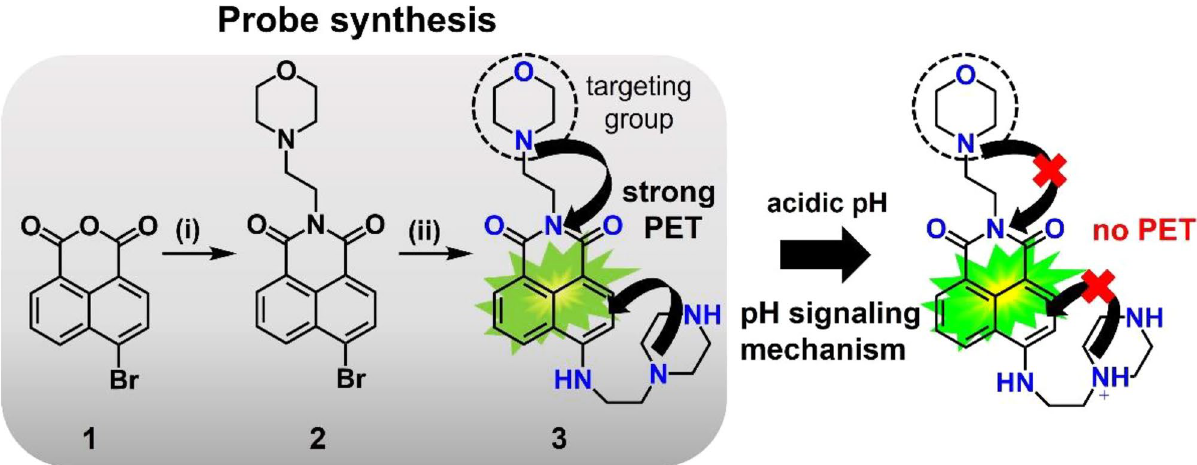
Figure 1. Synthesis of the hydrophilic neutral optical pH probe 3 designed for lysosomal targeting and its pH signaling mechanism; (i) 4-(2-Aminoethyl) morpholine, ethanol, 50 °C,5 h; (ii) 1-(2-Aminoethyl) piperazine, triethylamine, pyridine, reflux, overnight. The pH signaling mechanism of 3 relies on an intramolecular photoinduced electron transfer (PET) from the unprotonated nitrogen atoms of the piperazine and morpholine units to the naphthalimide chromophore. Nitrogen protonation results in the blocking of these fluorescence quenching PET processes leading to the appearance of the chromophore’s green fluorescence at acidic pH values as confirmed in the following sections.